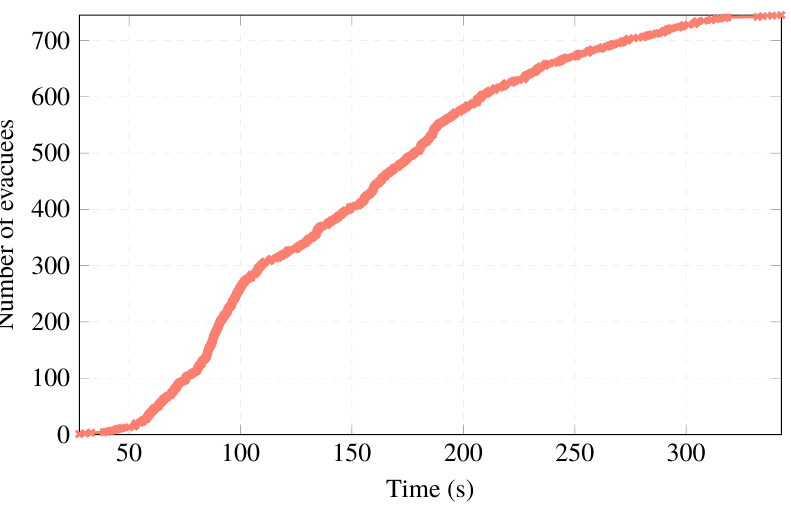
Figure 11. Dispersion diagram, time per number of evacuees (GQ situation, SIMONE).